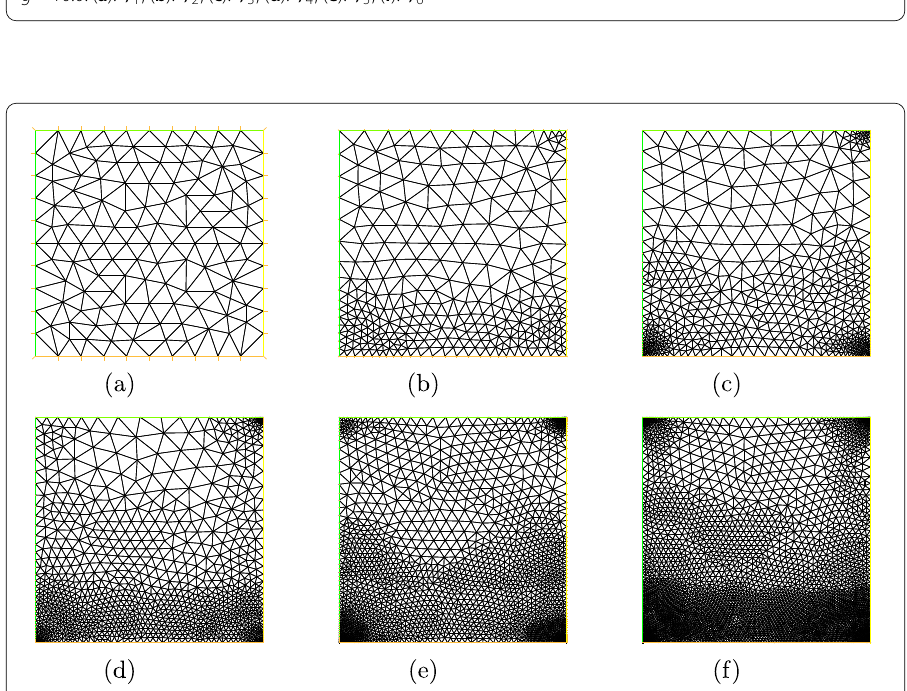
Figure 9 Adaptive refinements by P 1 – P 1 stabilized method for the cavity flow with slip boundary condition: g = 10.0. ( a ): T 1 ; ( b ): T 2 ; ( c ): T 3 ; ( d ): T 4 ; ( e ): T 5 ; ( f ): T 6